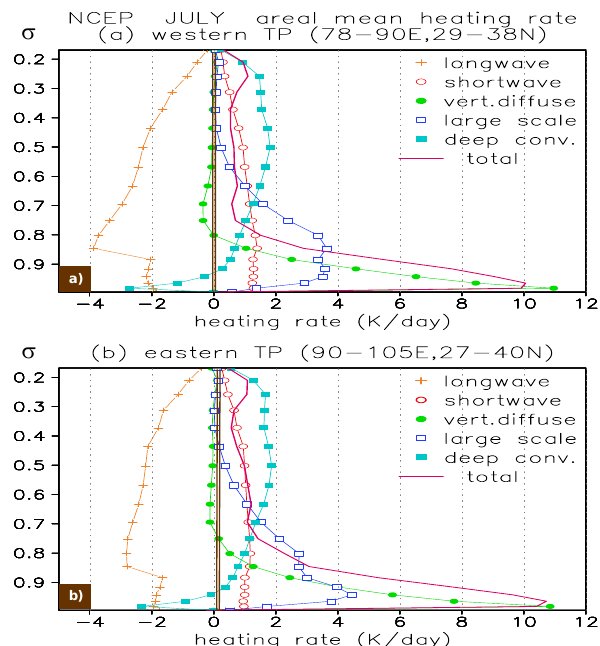
Fig. 9. July mean vertical profiles in σ -coordinate of various heat- ings over (a) the western Tibetan Plateau (78–90 ◦ E, 29–38 ◦ N) and (b) the eastern Tibetan Plateau (90–105 ◦ E, 27–40 ◦ N). Lines with “plus” signs, open circles, filled circles, open squares, and filled squares represent long-wave radiative cooling, short-wave radiative heating, vertical diffusive heating, large-scale condensation heating, and convective condensation heating, respectively. Red solid lines indicate total heating. Unit is Kd − 1